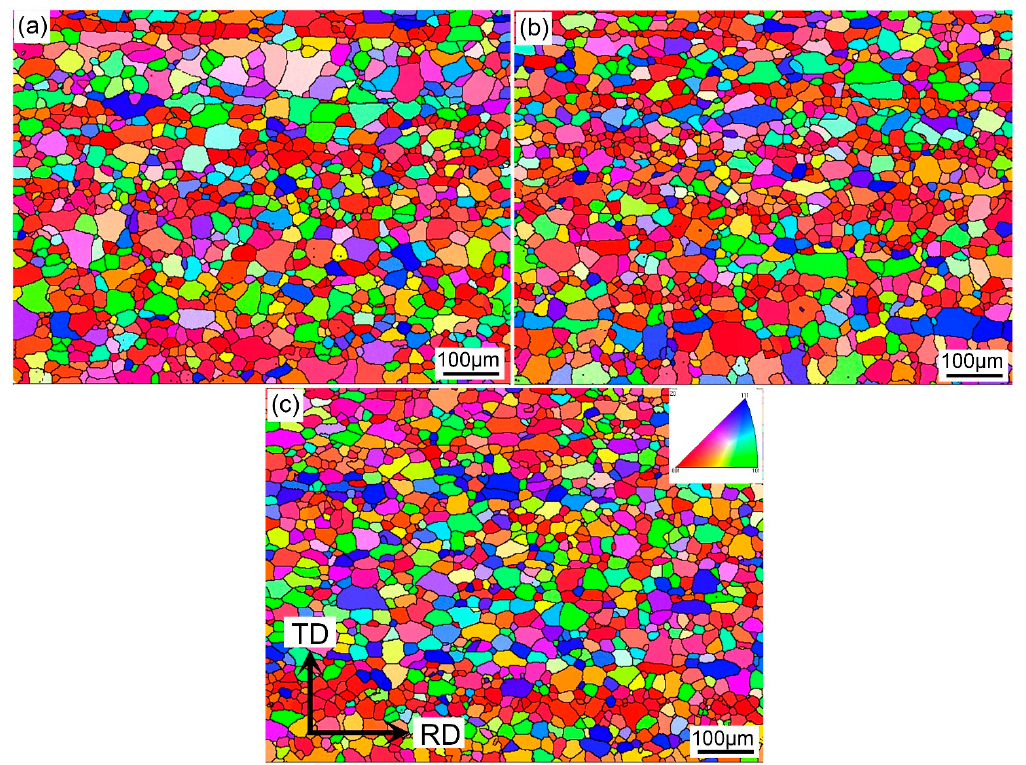
Figure 8. Inverse pole figure (IPF) maps showing the recrystallized grains and texture of the samples with different quenching rates after solution treatment: ( a ) 58.9 °C/s, ( b ) 7.0 °C/s, and ( c ) 1.9 °C/s.